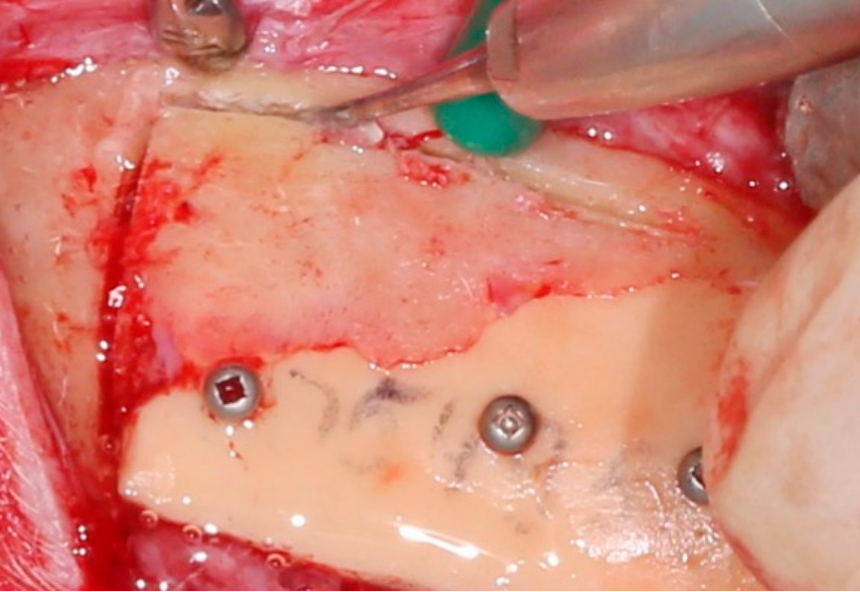
Figure 4. Excision of the plastic implant three months after primary surgical intervention.